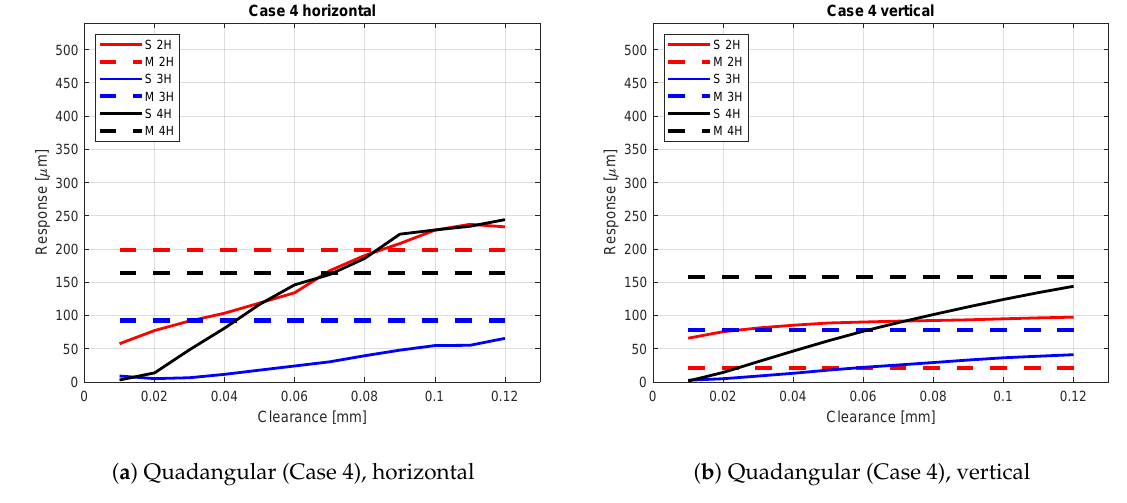
Figure 14. Case 4—quadrangular bearing inner ring roundness profile in the service